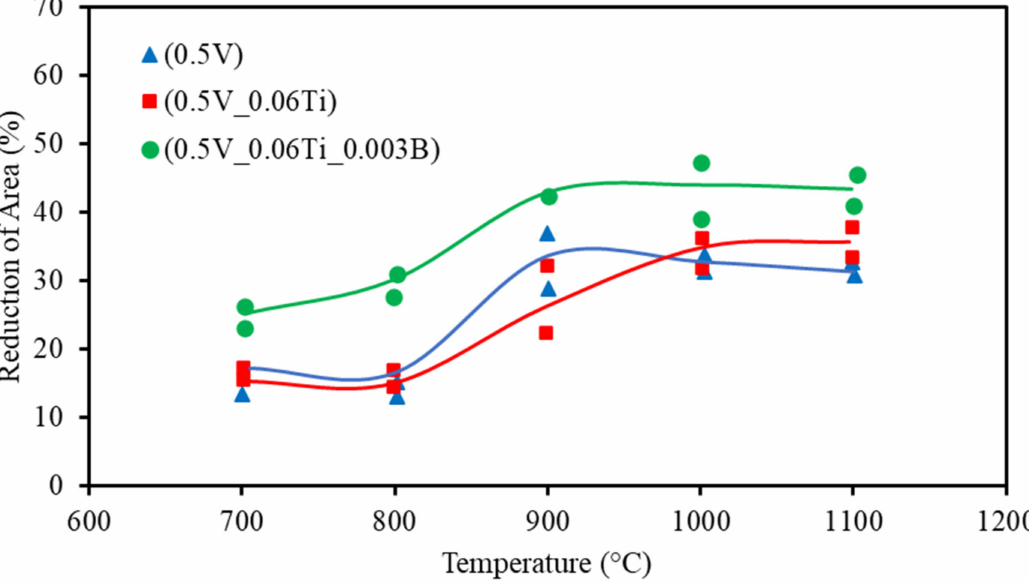
Figure 28. The beneficial influence of B on the hot ductility of a high V (0.5% V), TWIP steel